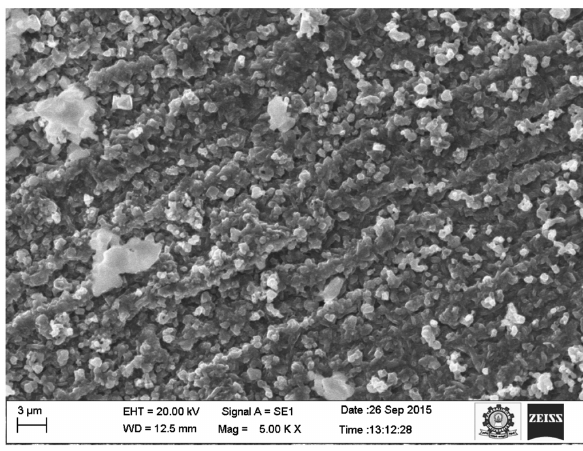
Figure 4: SEM micrograph showing oxidize nucleation on Hastealloy X exposed to air at